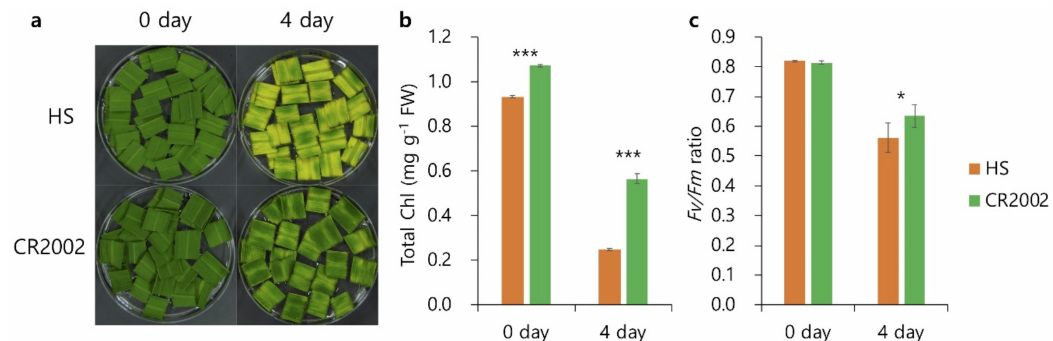
Figure 2. CR2002 showed delayed senescence under dark-induced senescence (DIS) conditions. Hwaseong and CR2002 were grown in a paddy field, and fully expanded flag leaves at the heading stage were used for DIS. ( a ) Detached leaves were incubated in 3 mM MES bu ff er (pH 5.8) at 27 ◦ C under dark conditions. ( b , c ) Total chlorophyll contents ( n = 6) and Fv / Fm ratio ( n = 5) were compared between Hwaseong and CR2002. Error bars indicate a standard error, and more than three samples were used for each experiment. * and *** indicate significant di ff erence at p < 0.05 and p < 0.001 based on Student’s t -test,